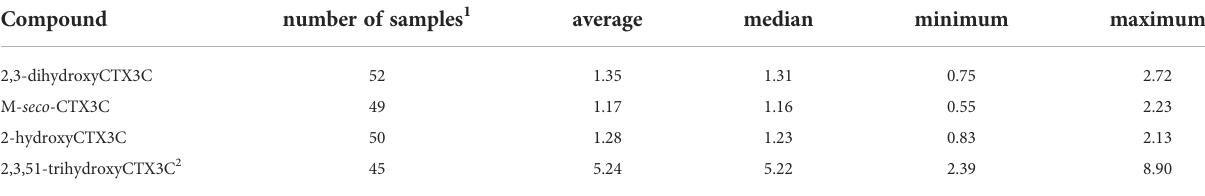
TABLE 2 Quotient determined for the peak areas of the 49R-congener and 49-epimer or 49R-congener and potential isomer. Compound